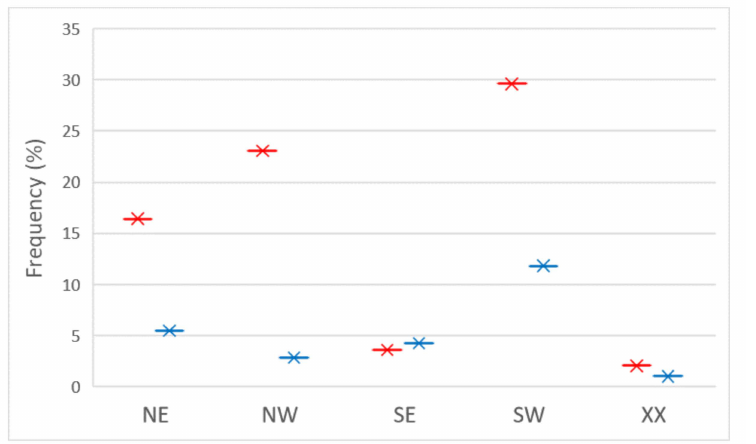
Figure 6. Frequency of anticyclonic (red) and cyclonic (blue) types of circulation in Kłodzko Land in the summer seasons (June–August) of the 1971–2010 period, based on H. Ojrzy´nska’s classifica- tion